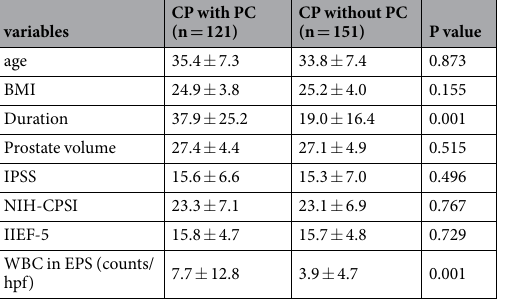
CP with PC (n = 121)